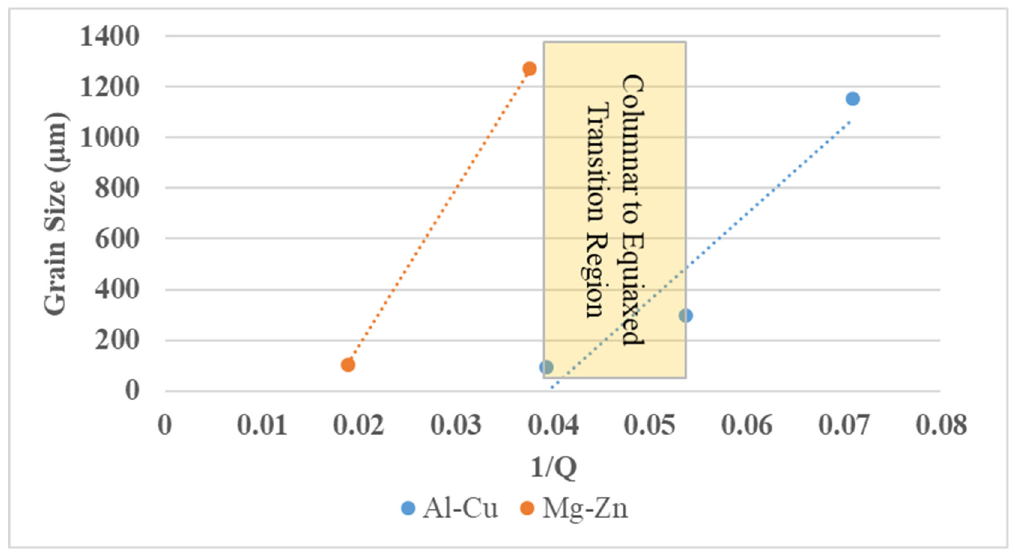
Figure 9. Grain size versus 1/Q for Al and Mg